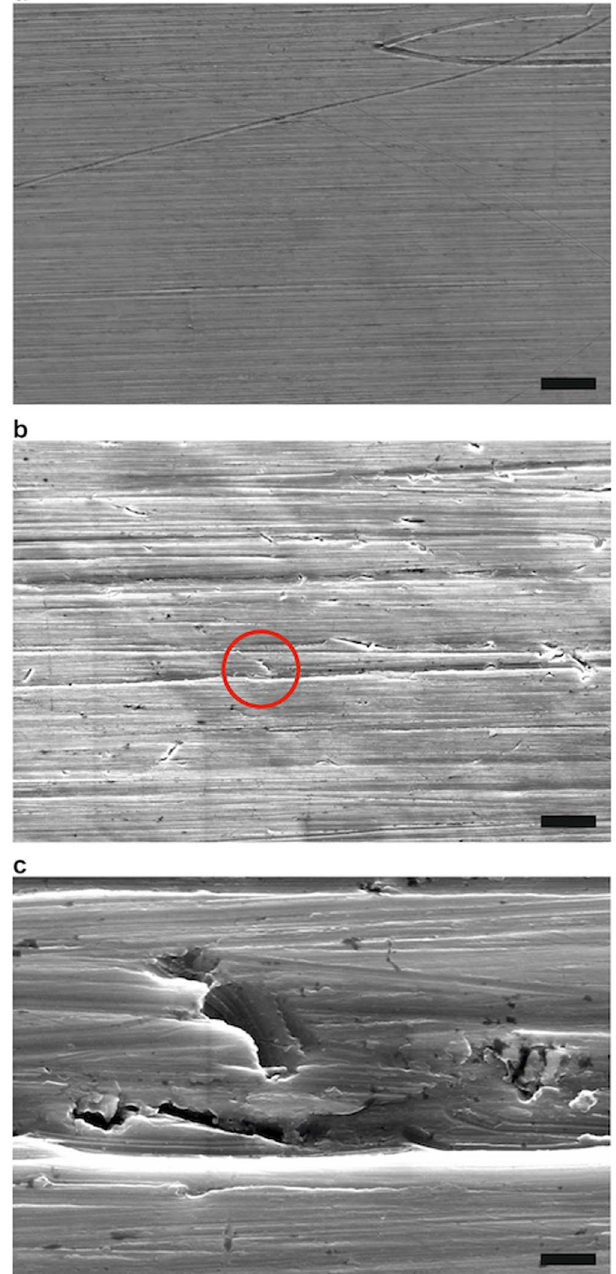
Figure 2. Characterization of the lateral surface of the sinkers using scanning electron microscopy. Images: ( a ) Polished lateral surface of density sinker (scale bar: 20 μ m). ( b ) Surface of sorption sinker as machined (scale bar: 20 μ m); the red circle indicates a selected imperfection, which is enlarged in ( c ) (scale bar: 2 μ